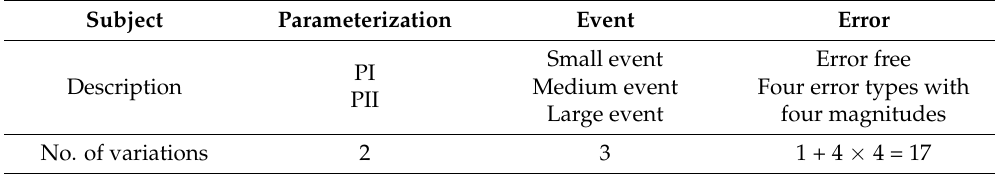
Table 1. Overview of the 102 cases (synthetic time series) used in this